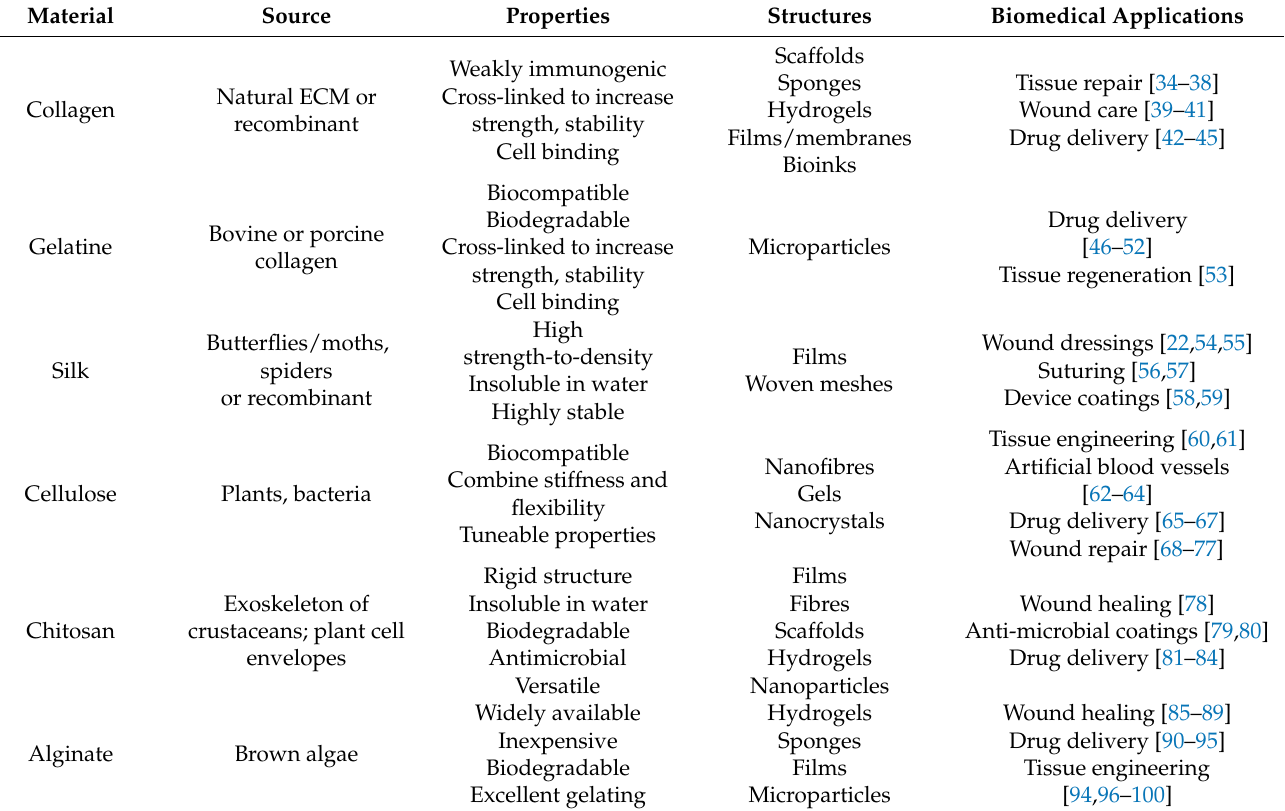
Table 1. Summary of the different protein and polysaccharide-based biomaterials, their sources, main properties, structural forms used in biomedicine and biomedical